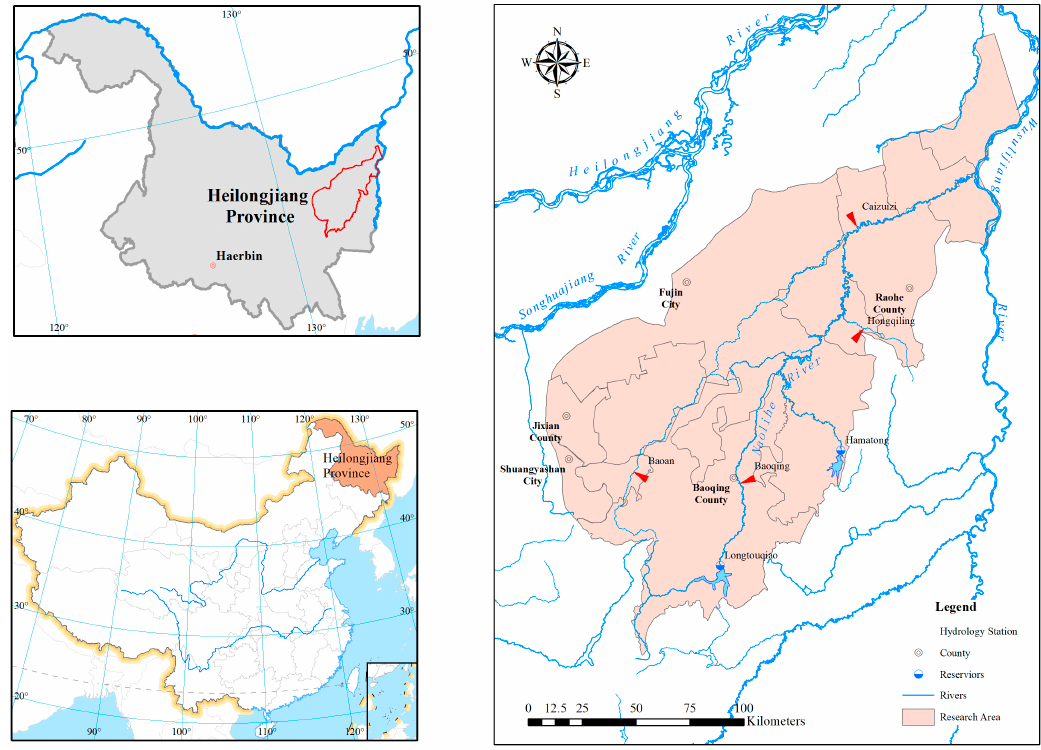
Figure 1. Location of the study area.